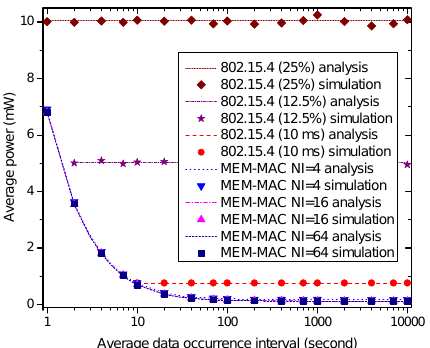
Figure 12. How the coordinator average power changes with the average data occurrence